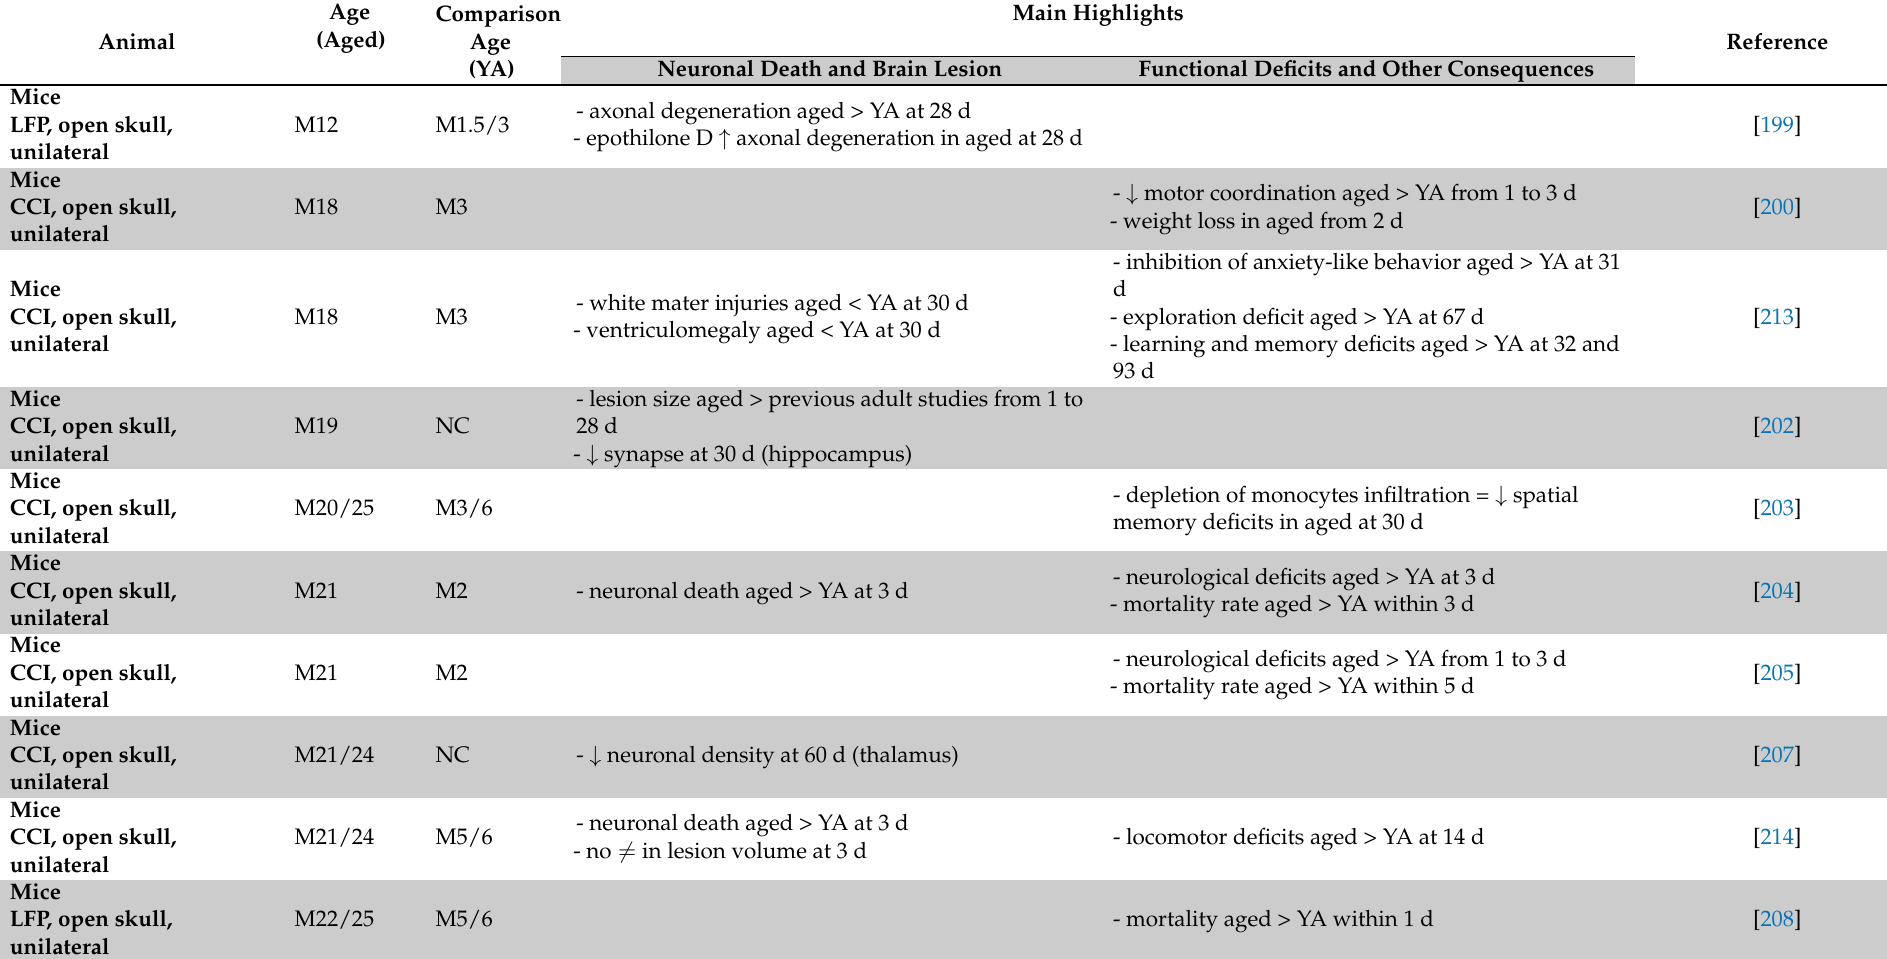
Table 5. Post-traumatic neuronal, tissue and functional consequences on aged animals. Abbreviations: ↑ : increase; ↓ : decrease; BBB: blood-brain barrier; CCI: controlled cortical impact; d: day post-injury; FP: fluid percussion; h: hour post-injury; LFP: lateral fluid percussion; M: post-natal month; NC: not compared; TBI: traumatic brain injury; W: post-natal week; YA: young adult